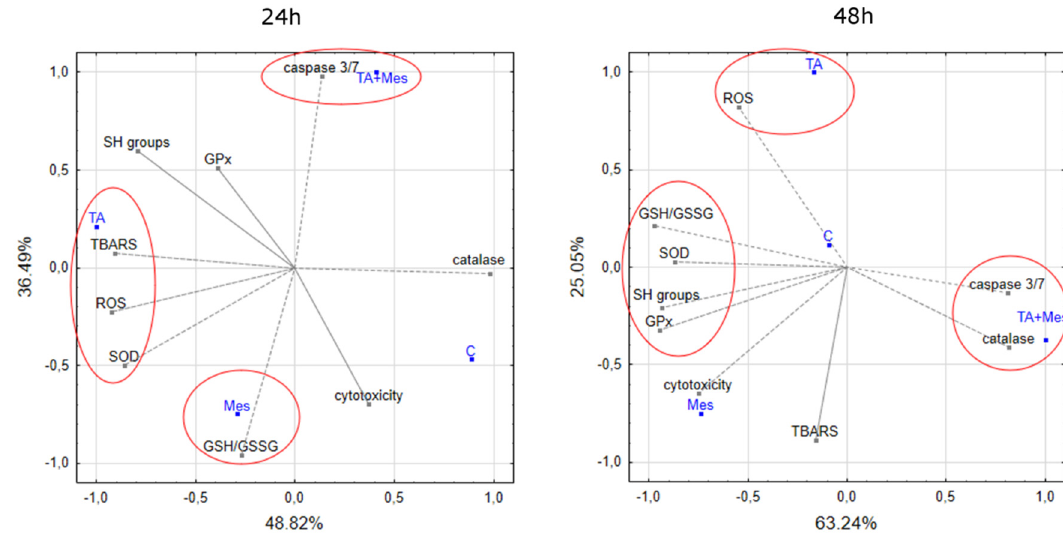
Figure 7. Biplot showing variables (SH groups (thiol groups), TBARS (thiobarbituric acid reactive species) content, GSH / GSSG ratio, ROS content, SOD, catalase, GPX activity, caspase 3 / 7 activity, cytotoxicity) and cases (tested compounds: Mes, TA, and TA + Mes—mix of two analyzed compounds) in two dimensions.